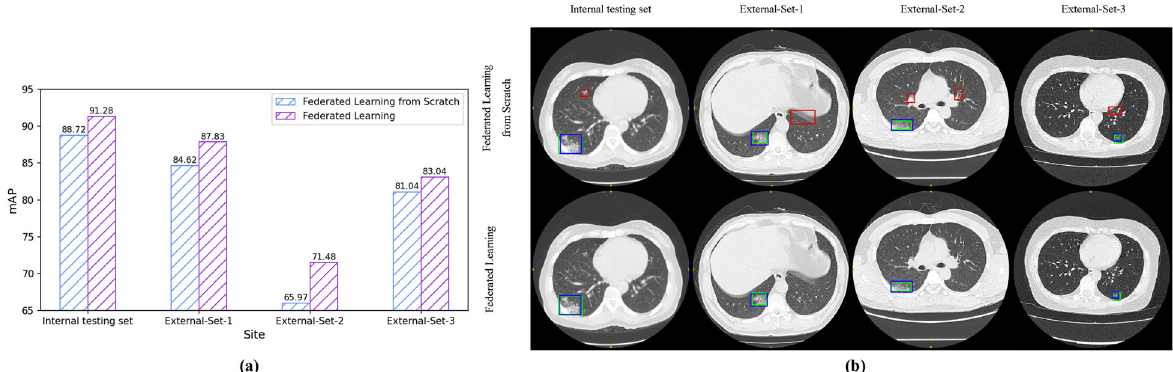
Fig. 4 Ablation experiments on federated learning method with and without transfer learning from model pretrained on DeepLesion dataset. Left bar chart shows the performance measured in mAP (mean Average Precision) of two different training strategies, federated learning outperforms federated learning from scratch over all datasets. Right part visualizes the predictions from two methods. The blue, green, and red bounding boxes denote model predictions, manual reference lesion regions, and false-positive predictions, respectively. Transfer learning from pretrained model is helpful to reduce false-positive